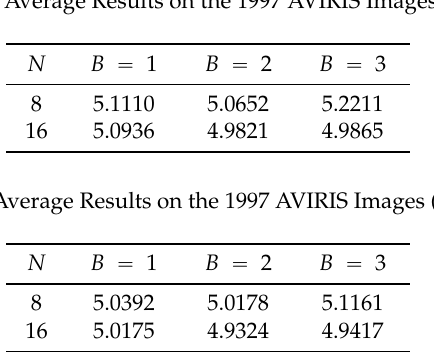
Table 8. Average Results on the 1997 AVIRIS Images (AC).